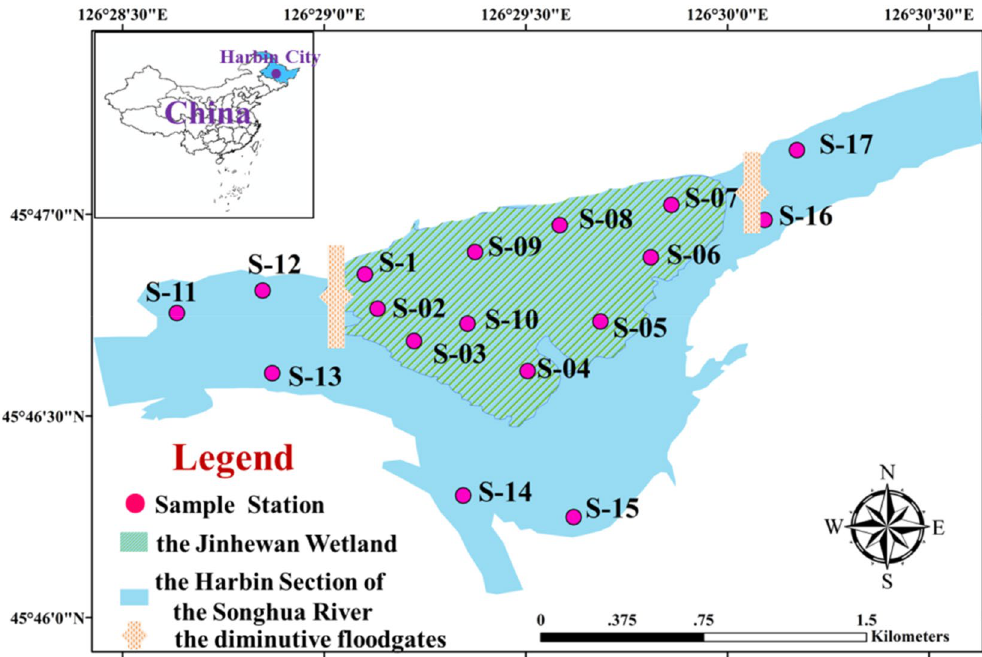
Figure 1. The location of sampling sties in study area. S1–S10 are located in Jinhewan Wetland, S11–S17 are located in the Harbin Section of the Songhua River. The map was generated by ArcGIS Desktop v10.2 (www. arcgi